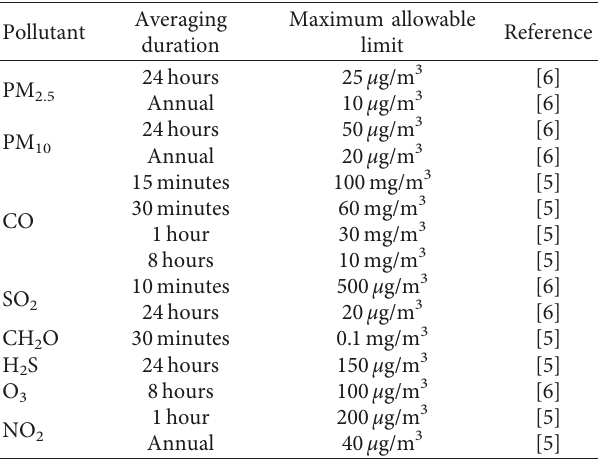
Table 5: WHO ambient air quality standards.